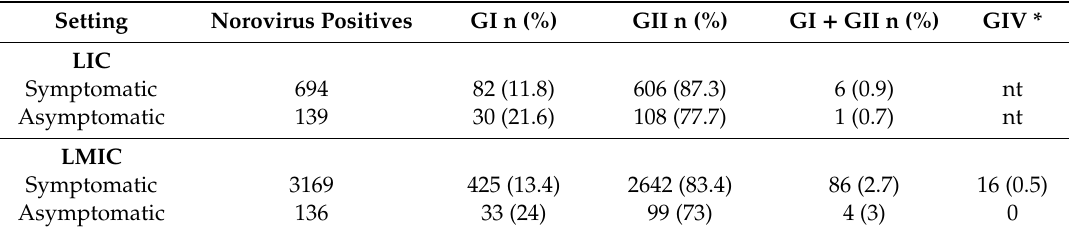
Table 2. The prevalence of norovirus GI, GII, and GIV in LIC and LMIC in symptomatic norovirus cases and asymptomatic